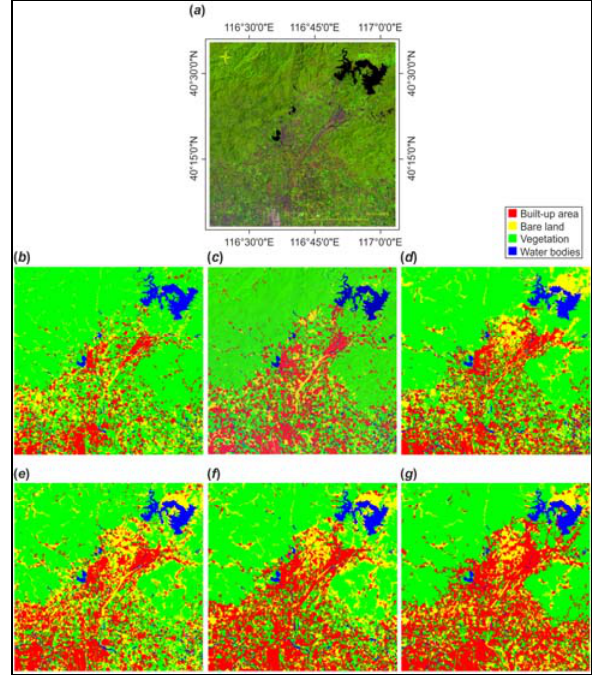
Figure 4. (a) Original satellite image of the study area, (b)-(g) the classification results of the study area from 2006 to 2011